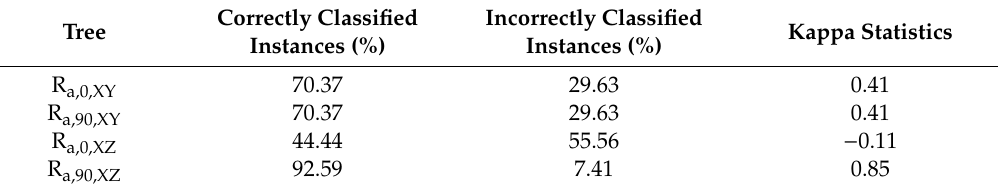
Figure 10. Decision tree for surface roughness measured in the direction perpendicular to the extrusion path on printed specimens in the XZ orientation (R a,90,XZ ). Table 9. Information regarding decision tree models generated in this work.